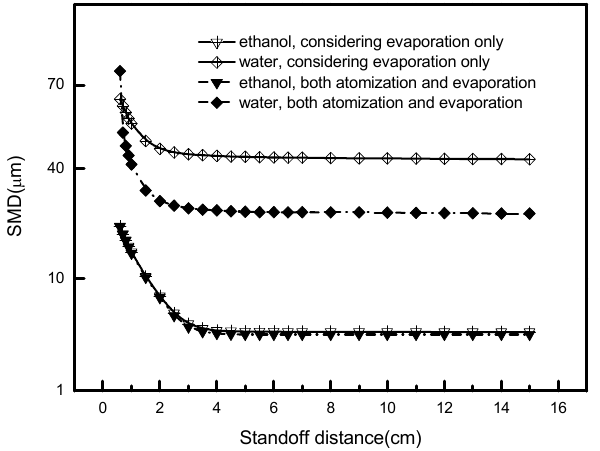
Figure 5. Effects of atomization and evaporation on the droplet mean size.